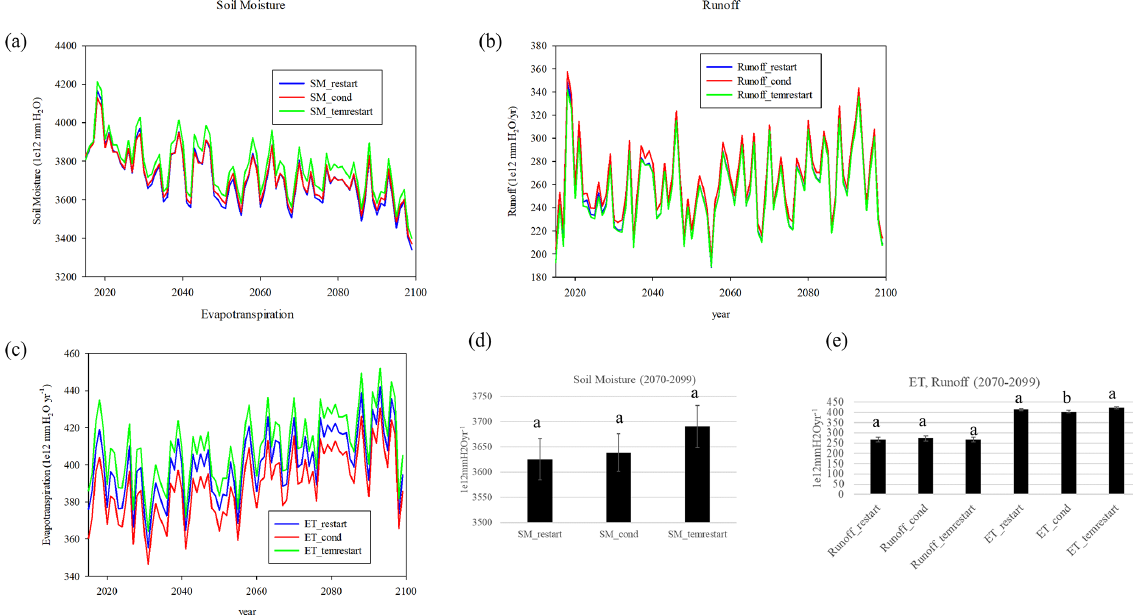
Figure 11. (a) Soil moisture, (b) runoff, and (c) evapotranspiration between the RESTART, CONDENSED, and TEMRESTART experiments; (d) mean differences 2070–2099 for soil moisture and (e) mean difference 2070–2099 for runoff and evapotranspiration (letters based on ANOVA analysis with P < 0 .